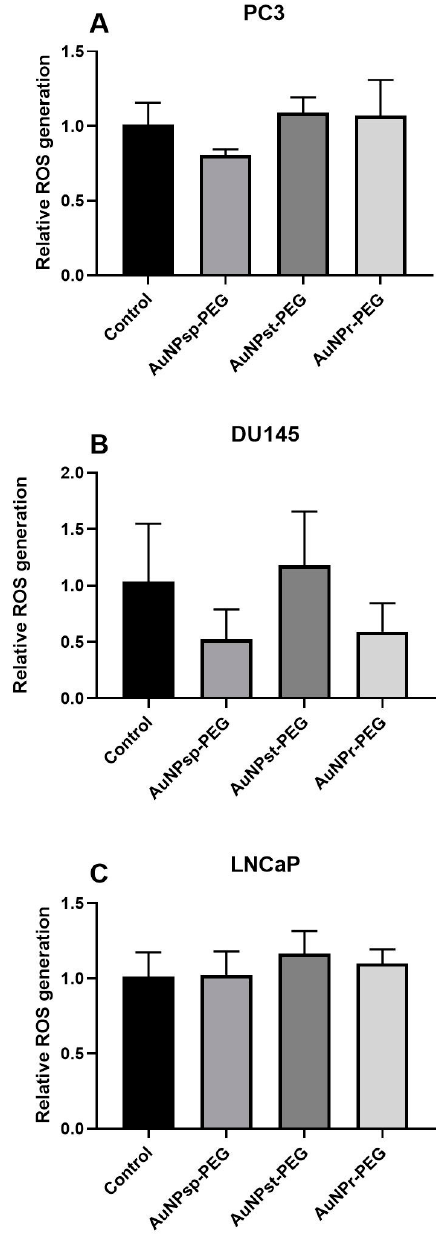
Figure 6. Different types of AuNPs-PEG in PC3 ( A ), DU145 ( B ), And LNCaP ( C ) in ROS levels. Cells were pretreated with 10 µM H2DCFDA for 45 min, then cells were treated with 0.1 mM AuNPs-PEG of different shapes during 24 h. Results represent the mean of DCF fluorescence (mean ± SD) from six independent replicates (n = 6).